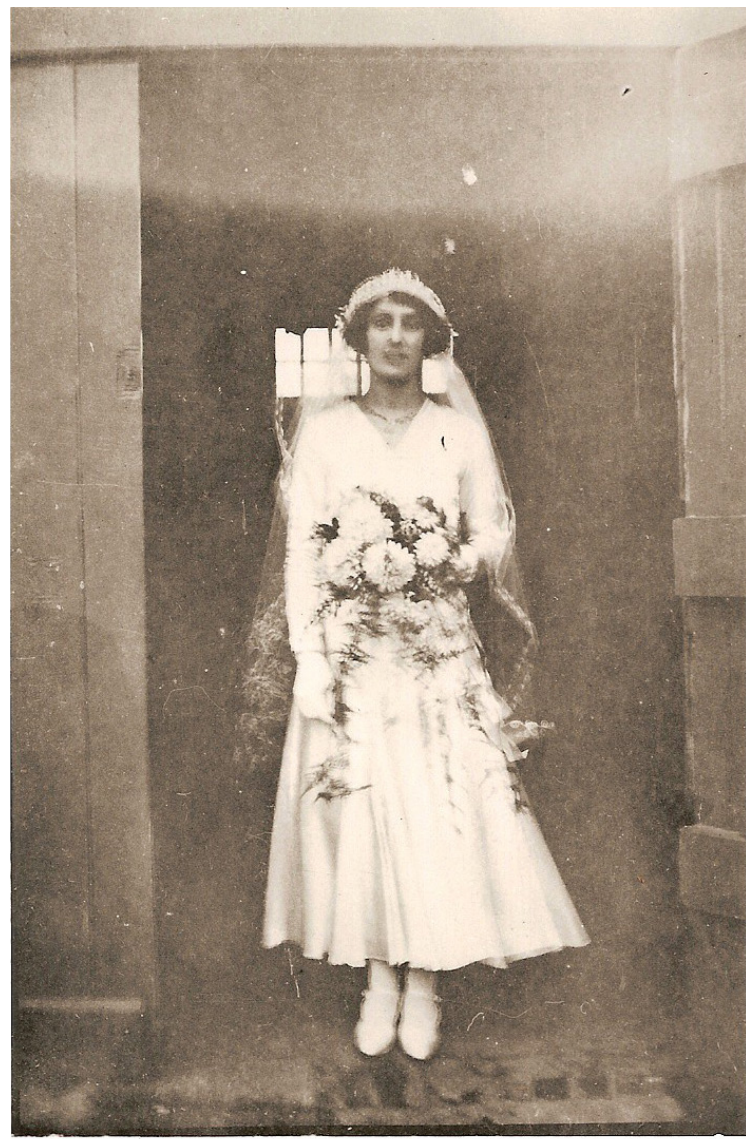
Figure 6.1 May Pitman on her wedding day. Photo: collection of Judith